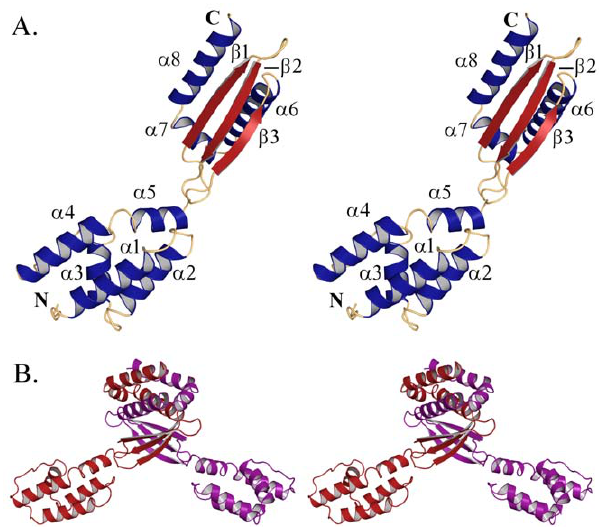
Figure 3. Stereo image of Cpn0803 monomer and dimer. The structure of full-length Cpn0803 was determined by SAD phasing of an anomalous data set collected from crystals of SeMet derivatized protein. The overall structure of Cpn0803 has a unique fold and no structural orthologs on the DALI server. A. Cartoon representation of the Cpn0803 monomer. Secondary structure elements are colored as follows; a - helices in blue and b -strands in red. B. Cartoon representation of the Cpn0803 dimer colored by chain.